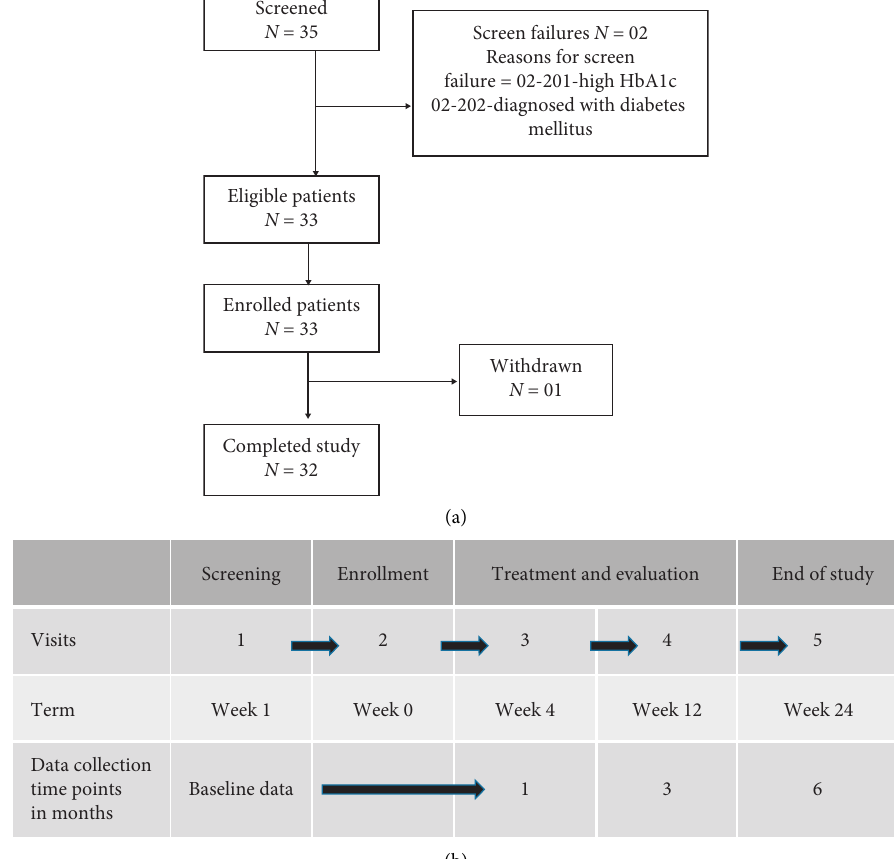
Figure 1: Schematic representation of the study design: (a) consort flow diagram and (b) sequence of events and time line of the